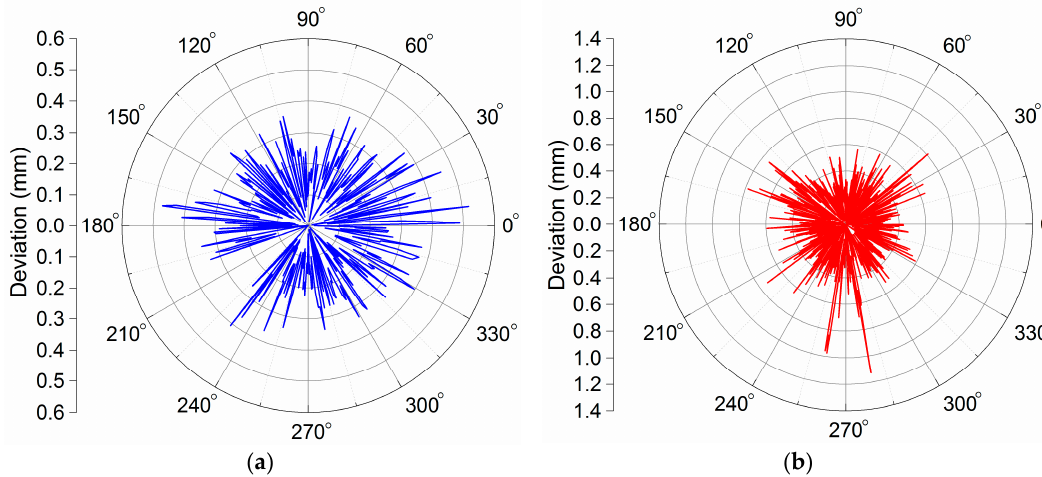
Figure 35. Deviation results of target planning path and actual tool path of experimental deburring for top facet (polar representation): ( a ) facet edges deburring deviation; ( b ) orifice edges deburring deviation. Appl. Sci. 2019 , 9 , x FOR PEER REVIEW